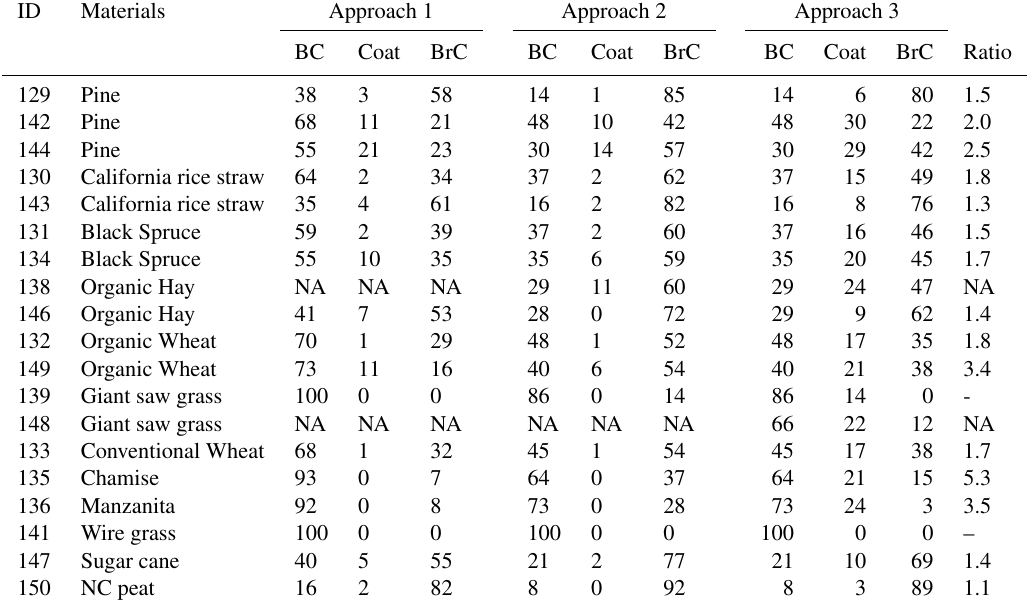
Table 1. Percentage of absorption due to BC, lensing (clear coating), and BrC from biomass burning aerosol emissions at 405nm estimated from three different approaches. The ID is the fire ID assigned during FLAME-4 for particular burns. The ratio in the rightmost column is the ratio in BrC absorption estimated by approach 2 vs. approach 1. Results where the BrC contribution was found to be zero by approach 1 are not assigned a ratio. NA indicates not